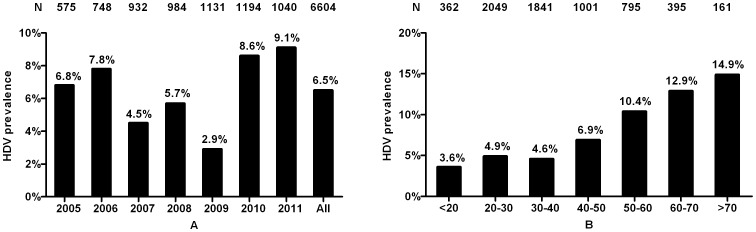
Distribution of HDV stratified by years and age.(A) Distribution of HDV stratified by years. The prevalence of HDV declined from 6.8% in 2005 to 2.9% in 2009, but then increased to 9.1% in 2011. The prevalence of HDV was 6.5% among all patients. (B) Distribution of HDV stratified by age. The prevalence of HDV correlated with age, with the lowest (3.6%) in patients under 20 years old and the highest (14.9%) in patients over 70 years old. Patients over 50 years old have higher frequencies of HDV compared to those under 50 (11.7% vs. 5.1%, P<0.001).